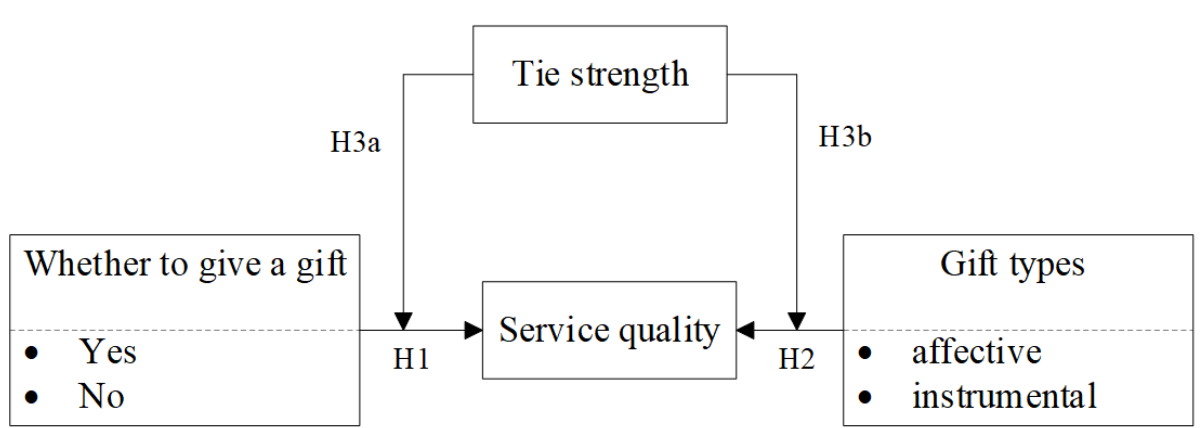
Figure 1. Conceptual